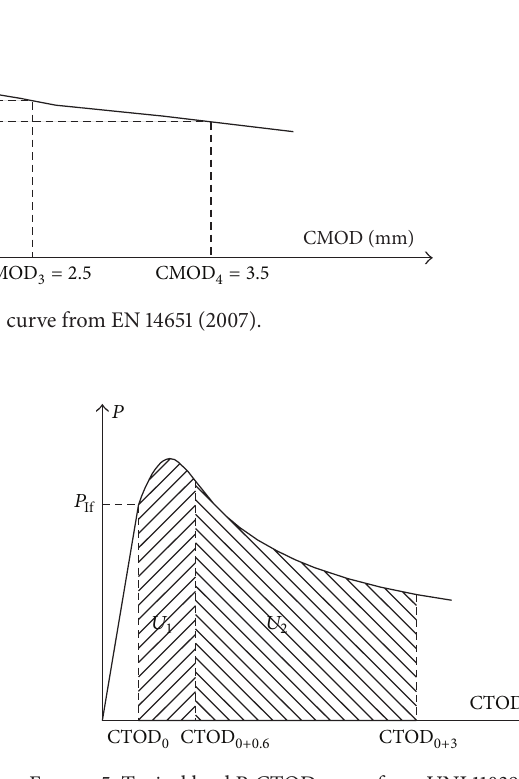
Figure 5: Typical load P-CTOD curve from UNI 11039-2 (2003).